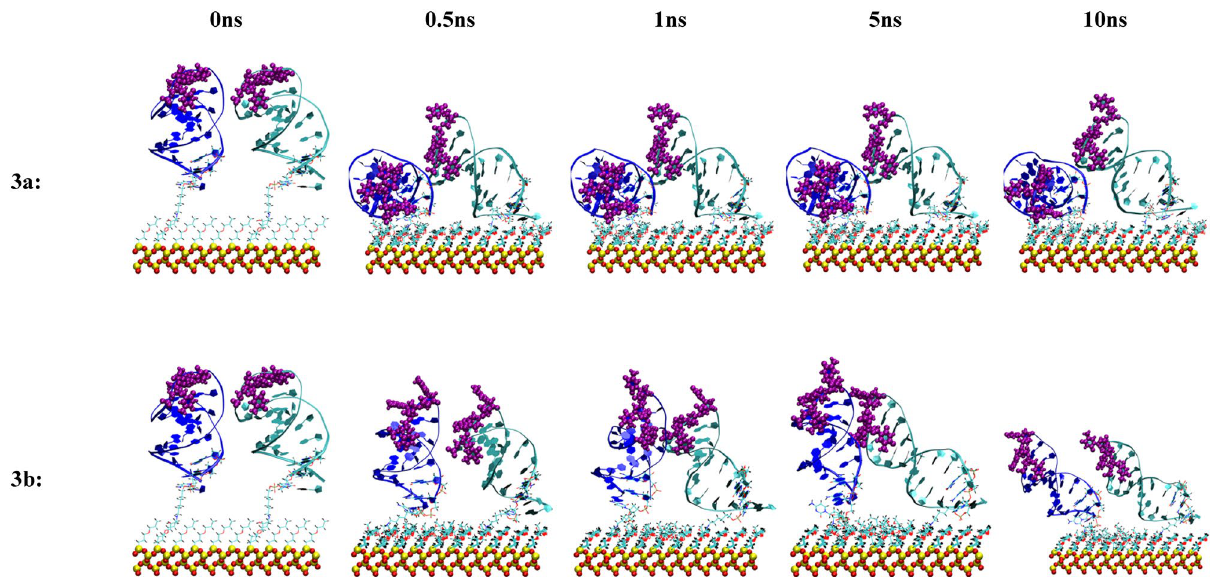
Figure 10. Snapshots of the MD simulation of two anti MUC1 aptamer tethered to the SiO 2 biosensor substrate in configuration 3 (5 ′ end attachment, perpendicular to surface, high density) neutralized (top) and in 0.8 M (bottom) solution concentrations at 0 ns, 0.5 ns, 1 ns, 5 ns, and 10 ns. The MUC1 binding residues (thymine residues 11 and 13) are displayed in purple. In each image, aptamer strand 1 is shown on the left and strand 2 is shown on the